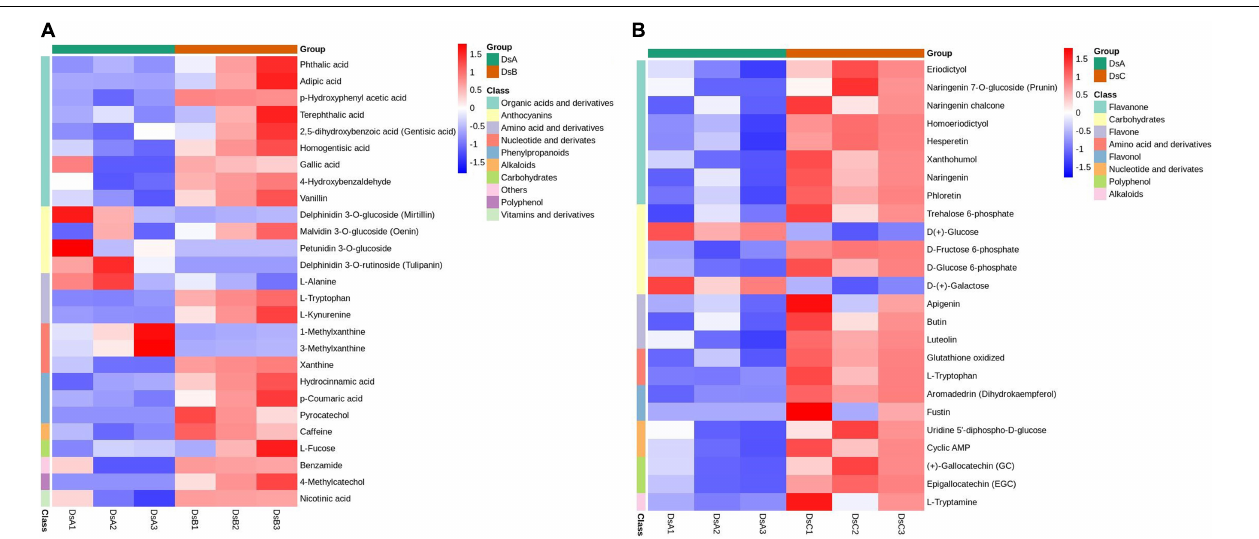
FIGURE 3 | Metabolites on metabolic pathways with significantly different enrichment. (A) Cluster analysis of DSB vs. DSA differential metabolites. (B) Cluster analysis of DSC vs. DSA differential metabolites. The analysis of hierarchical clustering for differential metabolism calculated by complete linkage approach. These metabolites were derived from metabolic pathways ( p < 0.05) in DSA vs. DSB and DSA vs. DSC. Red denotes metabolites with high content, and blue means low content. The agglomeration method to be used by hclust